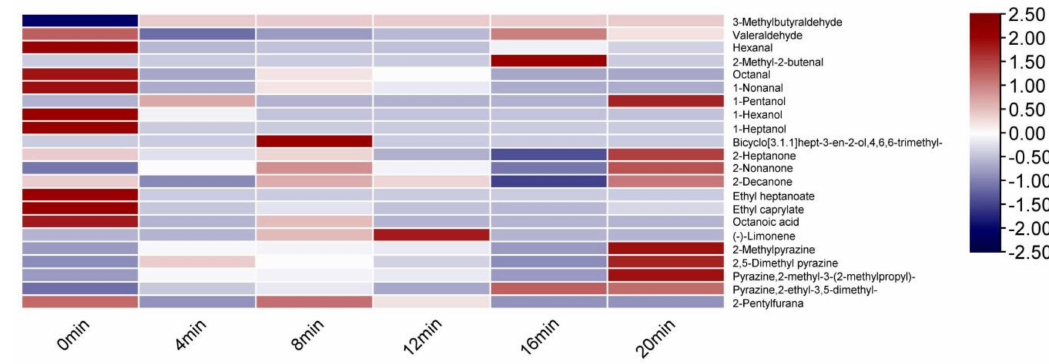
Figure 3. Heat map of ROAV of defatted tiger nut